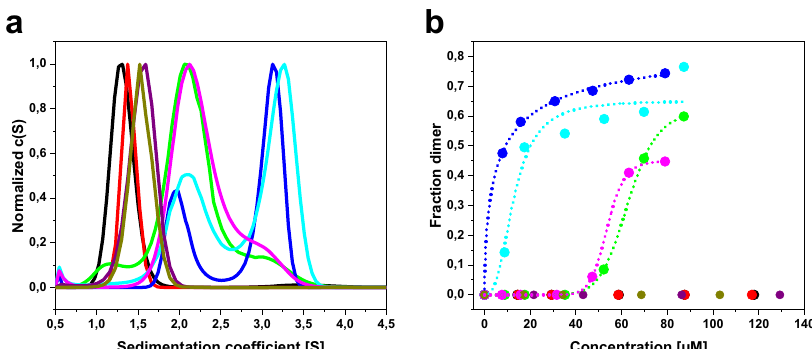
Fig. 6 Analytical ultracentrifugation shows that the C L mutation leads to diminished dimerization propensity. a Normalized sedimentation pro fi les of P-CL (black), G-CL (red), P-VL (purple), G-VL (olive), P-LC (green), G-LC (blue), P-LC G136V (cyan), and G-LC V136G (magenta). Protein concentration was adjusted to an absorbance of A 280 = 1.5. AUC raw data were analyzed with SEDFIT. b Fraction of noncovalent dimers dependent on protein concentration. The coloring scheme is the same as in ( a ). Data were fi tted using the Hill equation to determine the apparent K D values of the noncovalent LC dimerization. The fi ts were constrained to include a dimer fraction of 0 at 0 µ M protomer concentration. All AUC data are derived from single measurements at each LC concentration ( n = 1). The corresponding dimer and monomer percentages at each LC concentration are given in